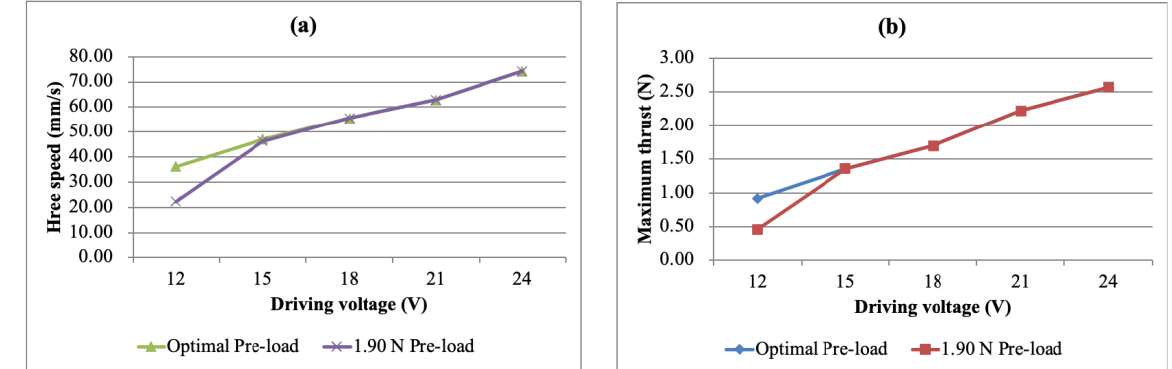
Figure 17. ( a ) Free speed and ( b ) maximum thrust figures as a function of the driving voltage for the multi-layer bimorph USM under different pre-loads. multi-layer bimorph USM under different